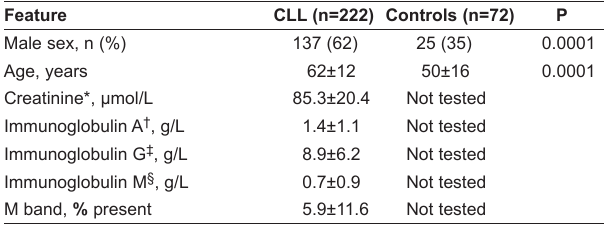
Table 2 Chronic lymphocytic leukemia (Cll) and healthy